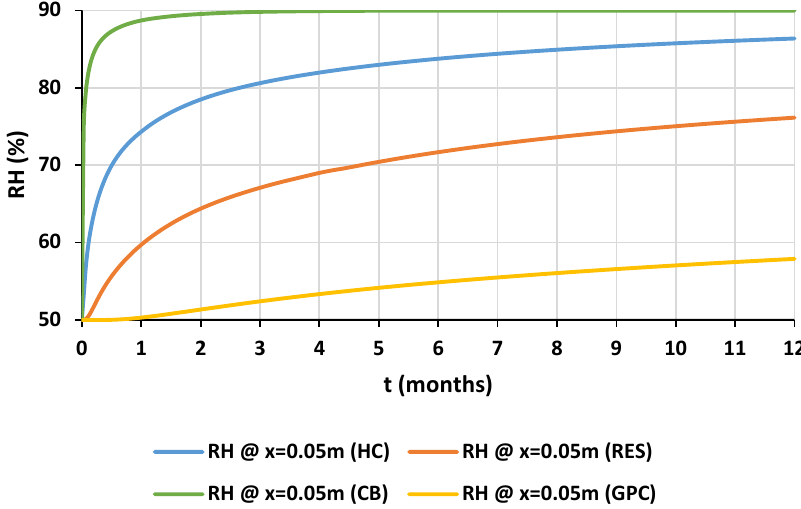
Figure 22. Yearly simulation of the evolution of RH and T at x = 0.05 m for HC, cob, and GPC.